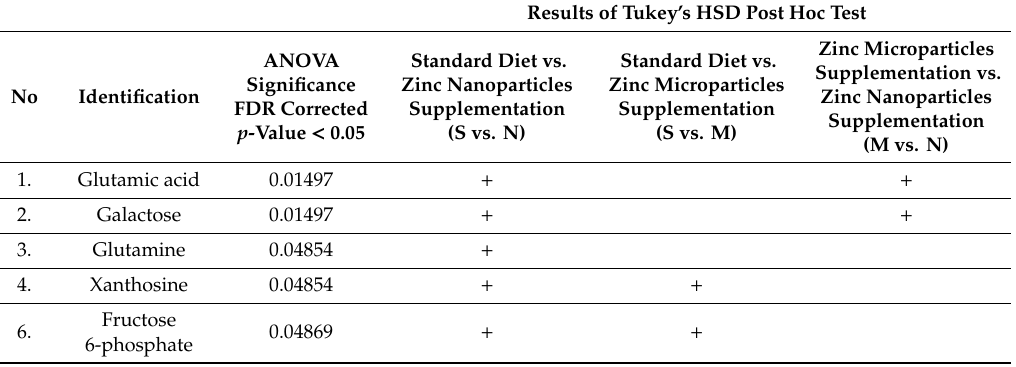
Figure 3. The principal component analysis used for the general data overview: rats on the standard diet (blue dots—s), with the zinc nanoparticles supplementation (green dots—n) and with the zinc microparticles supplementation (red dots—m). Table 3. Metabolites of altered abundance across three groups based on the one-way ANOVA test with results of post hoc tests indicating di ff erences between particular